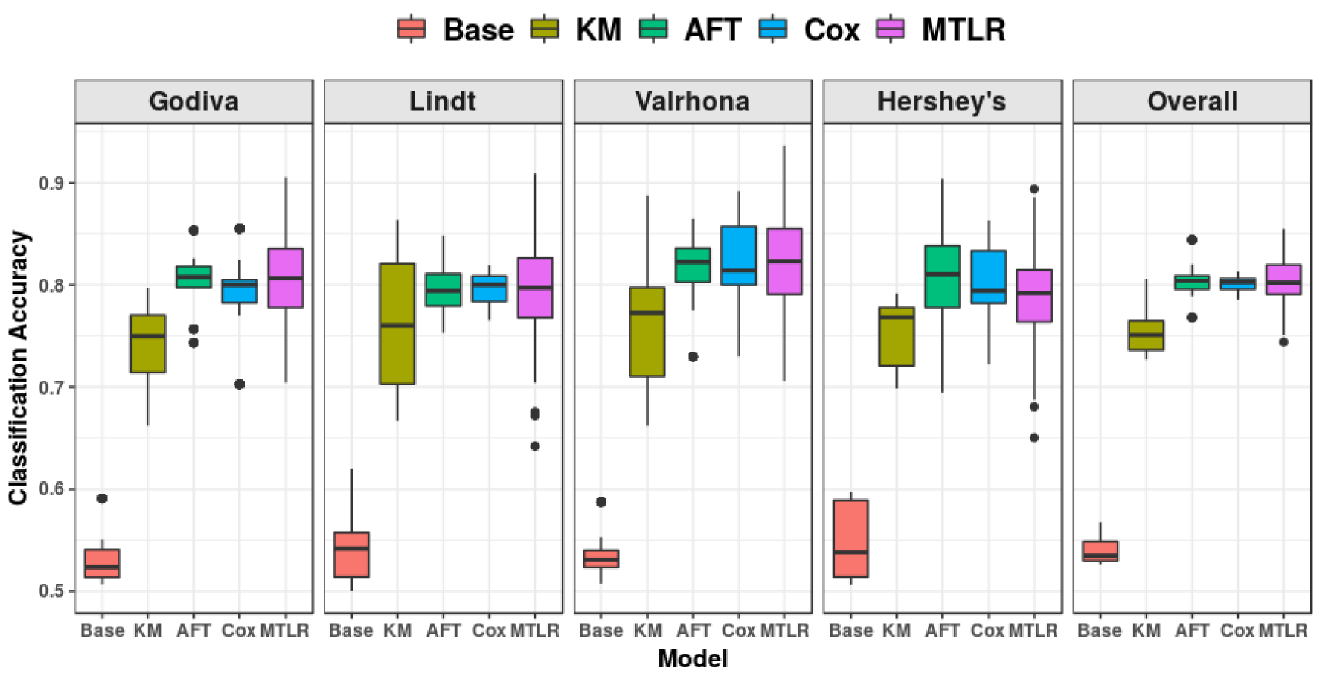
Fig 10. Ten-times repeated ten-fold cross validation classification accuracy, for each chocolate individually, and overall.